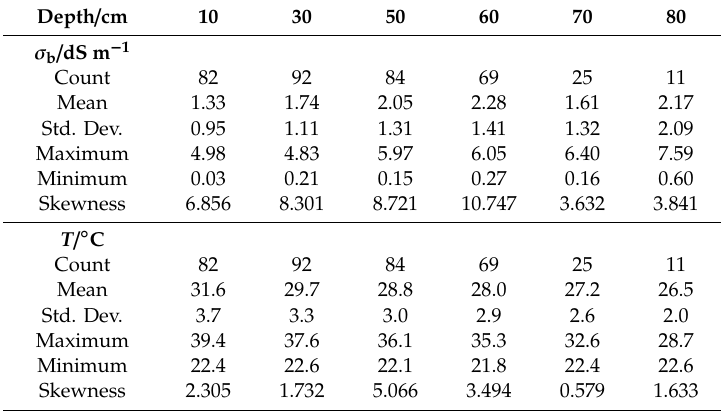
Table 3. Statistical summary of the soil bulk electrical conductivity ( σ b ) and temperature ( T ) measurements taken in the study area with the SCT-10 at di ff erent